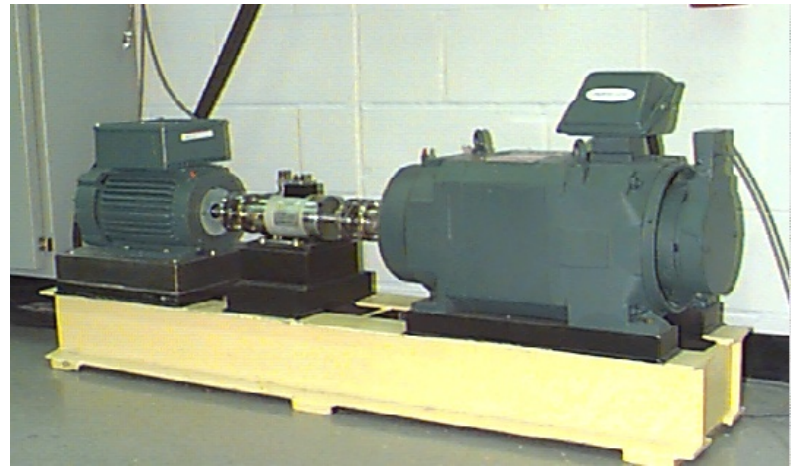
Figure 6. Two-horsepower ( left ), a torque transducer and encoder ( center ) and a dynamometer ( right ) used to collect the dataset. Table 2. The distribution of condition type samples in the cases.